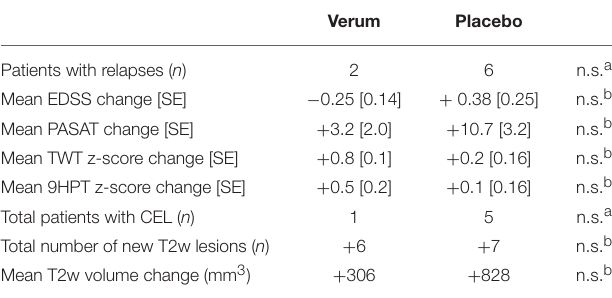
TABLE 2 | Main clinical and MRI outcome parameters after 12